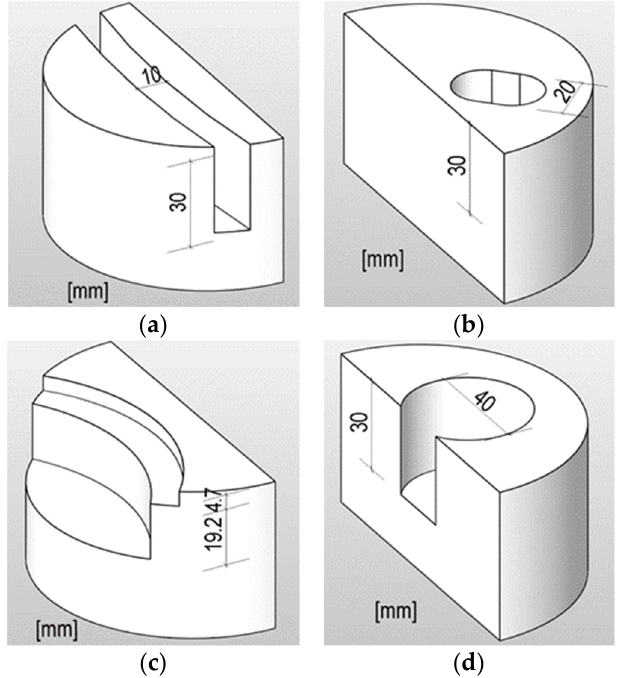
Figure 3. Geometries of the concrete powder samples after extraction (dimensions in mm); extraction method: ( a ) slot grinding; ( b ) oblong drill hole; ( c ) disc grinder; ( d ) wide drill hole.